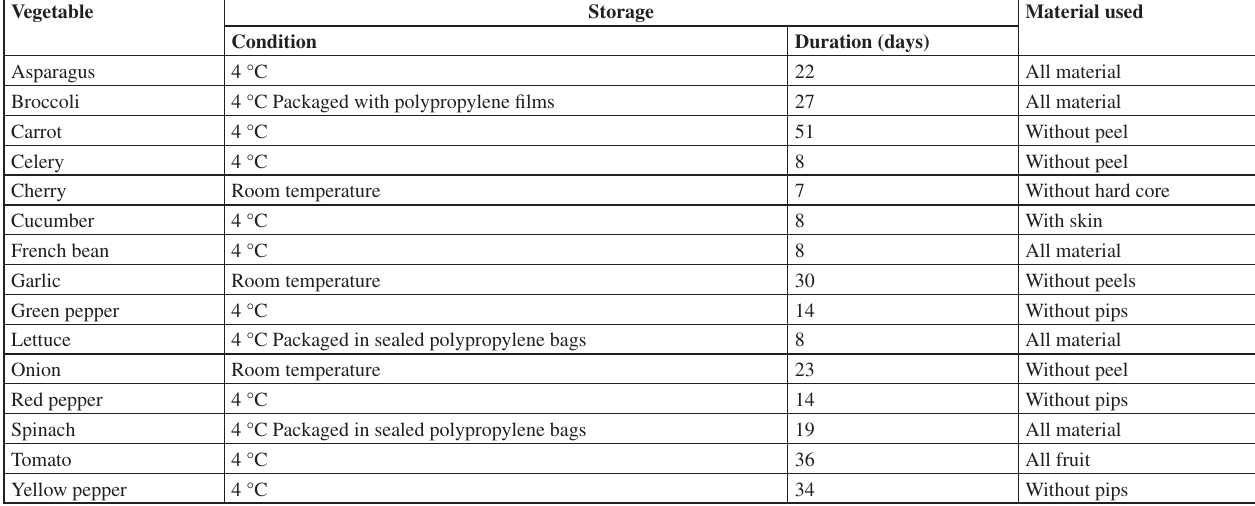
Water EC (dS m -1 )